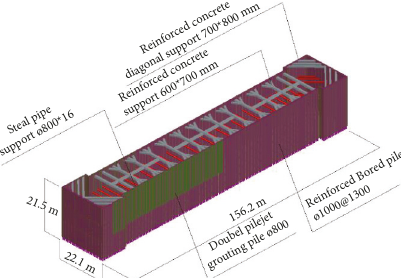
Figure 4: Schematic diagram of foundation pit support.